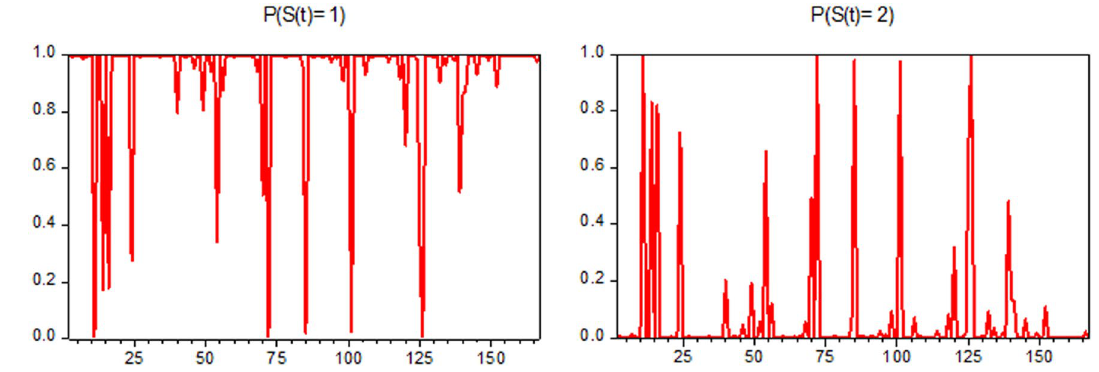
Fig. 8 The transition probabilities and the expected duration for the daily rainfall based on predicted the OK method